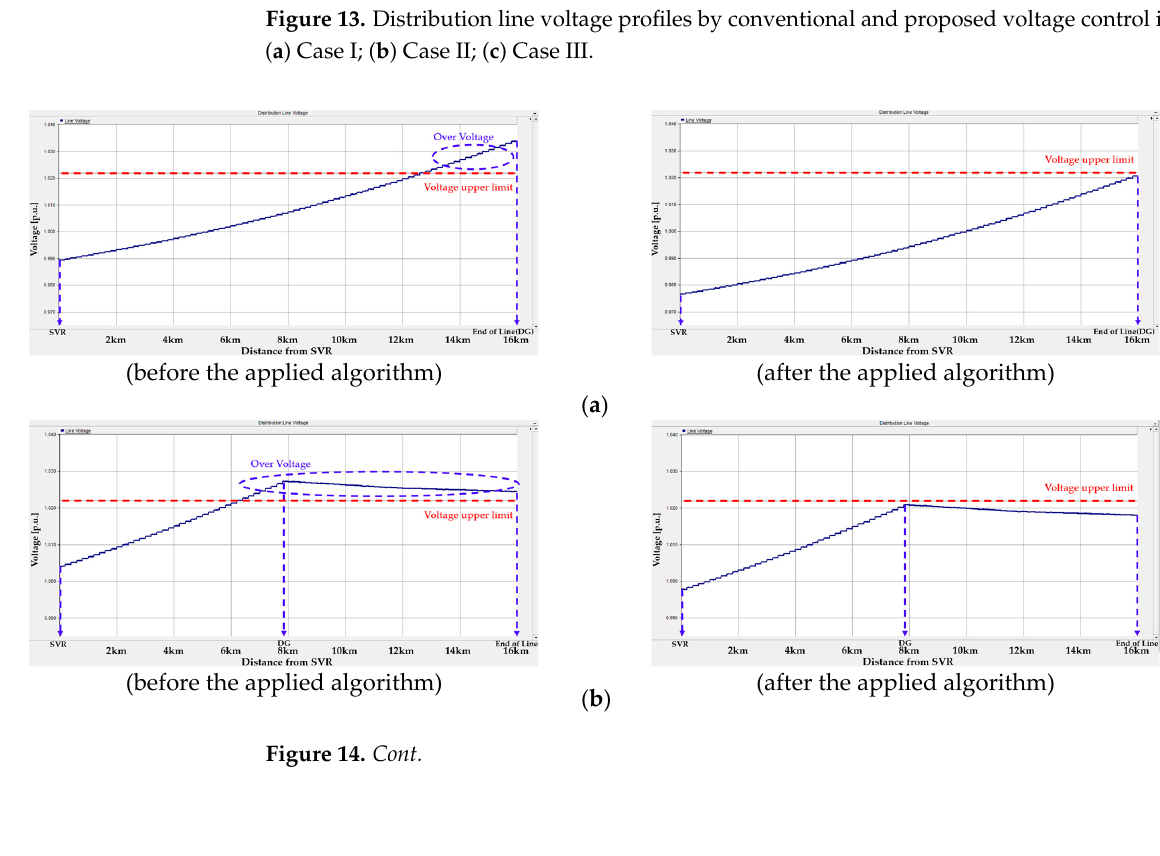
Figure 14. Distribution line voltage profiles by conventional and proposed voltage control in Type 3: ( a ) Case I; ( b ) Case II; ( c ) Case III. (after the applied algorithm)